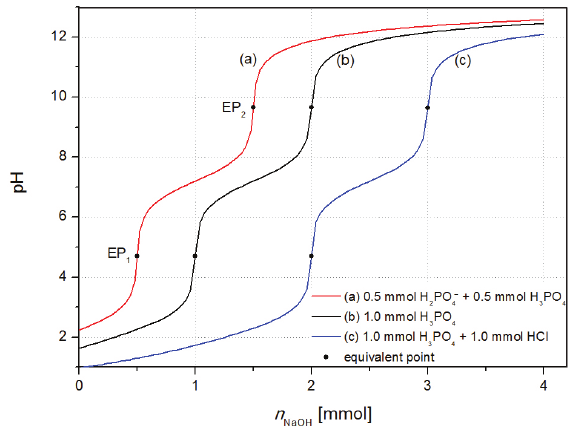
Figure 3. Simulated titration of 10 mL of a) 0.05 mmol H 0.05 mmol H mmol HCl with 0.20 M